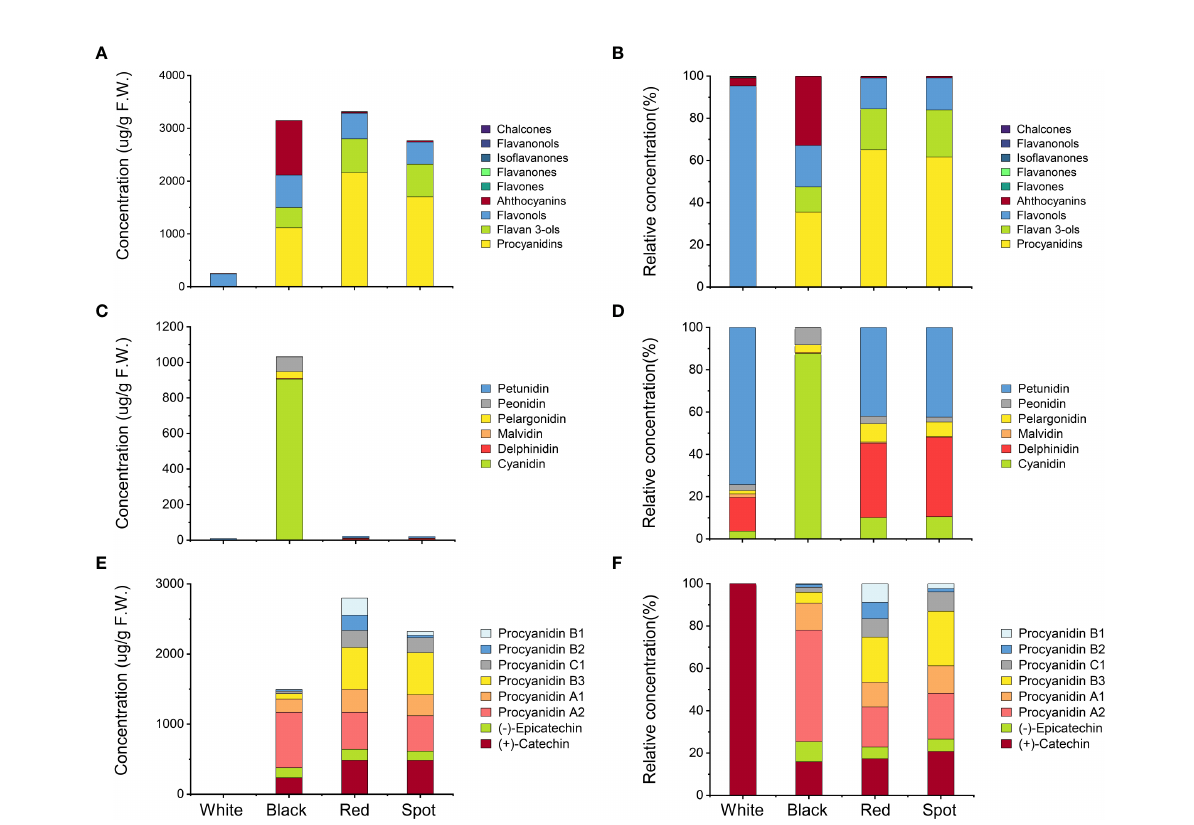
FIGURE 3 Absolute quali fi cation and relative contents of different types of fl avonoids in peanut seed coats. (A) Absolute, and (B) relative of concentrations of nine fl avonoid subgroups; (C) absolute, and (D) relative of concentrations of six subclasses of anthocyanins. (E) absolute, and (F) relative of concentrations of oligomeric procyanidins and monomeric fl avan-3-ols. The relative contents refer to the percentage of the amount of one component (or a subgroup of fl avonoids) in the total amount of all components (or all subgroups of fl avonoids) detected in the samples. The detail data were list in Table